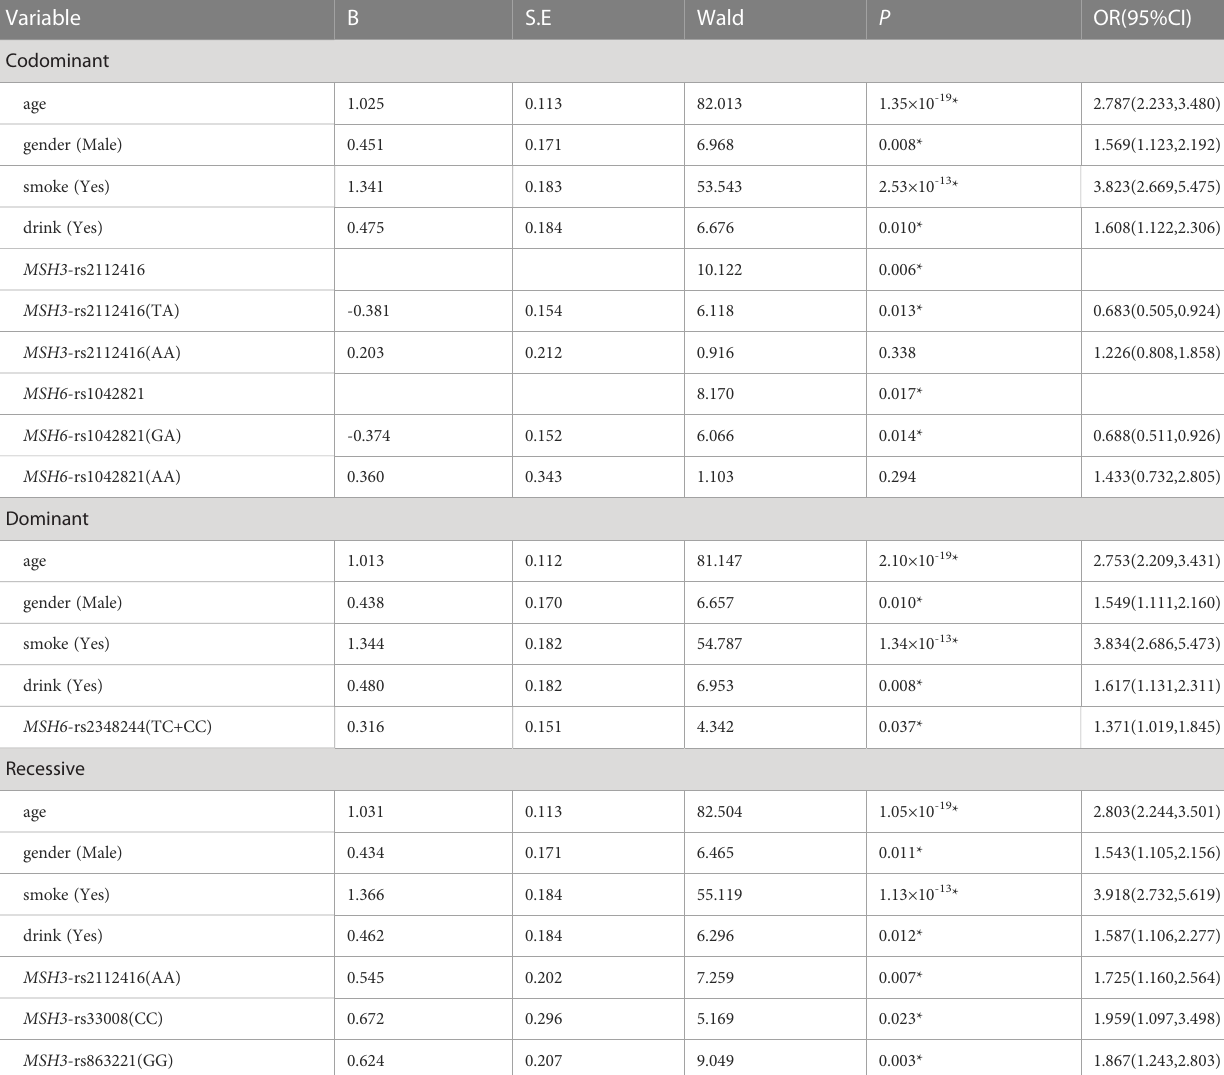
TABLE 1 Multiple logistic regression analysis of predictive factors for hepatocellular carcinoma between HC and HCC in three